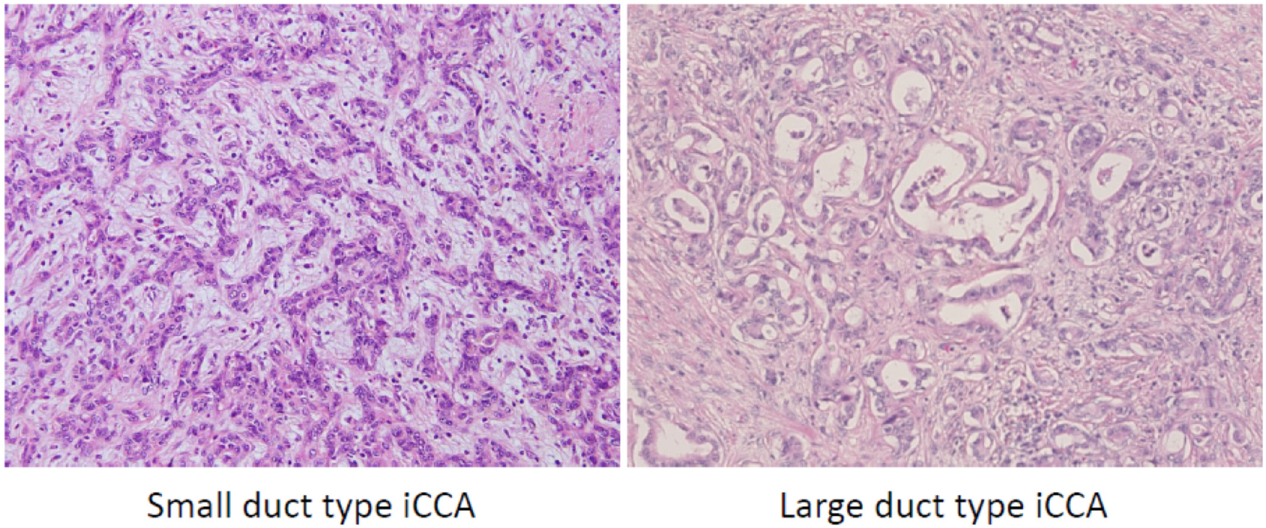
Figure 4. Pathological features of intrahepatic cholangiocarcinoma (iCCA) subtype. Small duct type iCCA shows ductular reaction-like structure with edematous stroma accompanying inflammatory cell infiltration, whereas large duct type iCCA shows clear glandular structure with hyalinized stroma (hematoxylin and eosin staining).